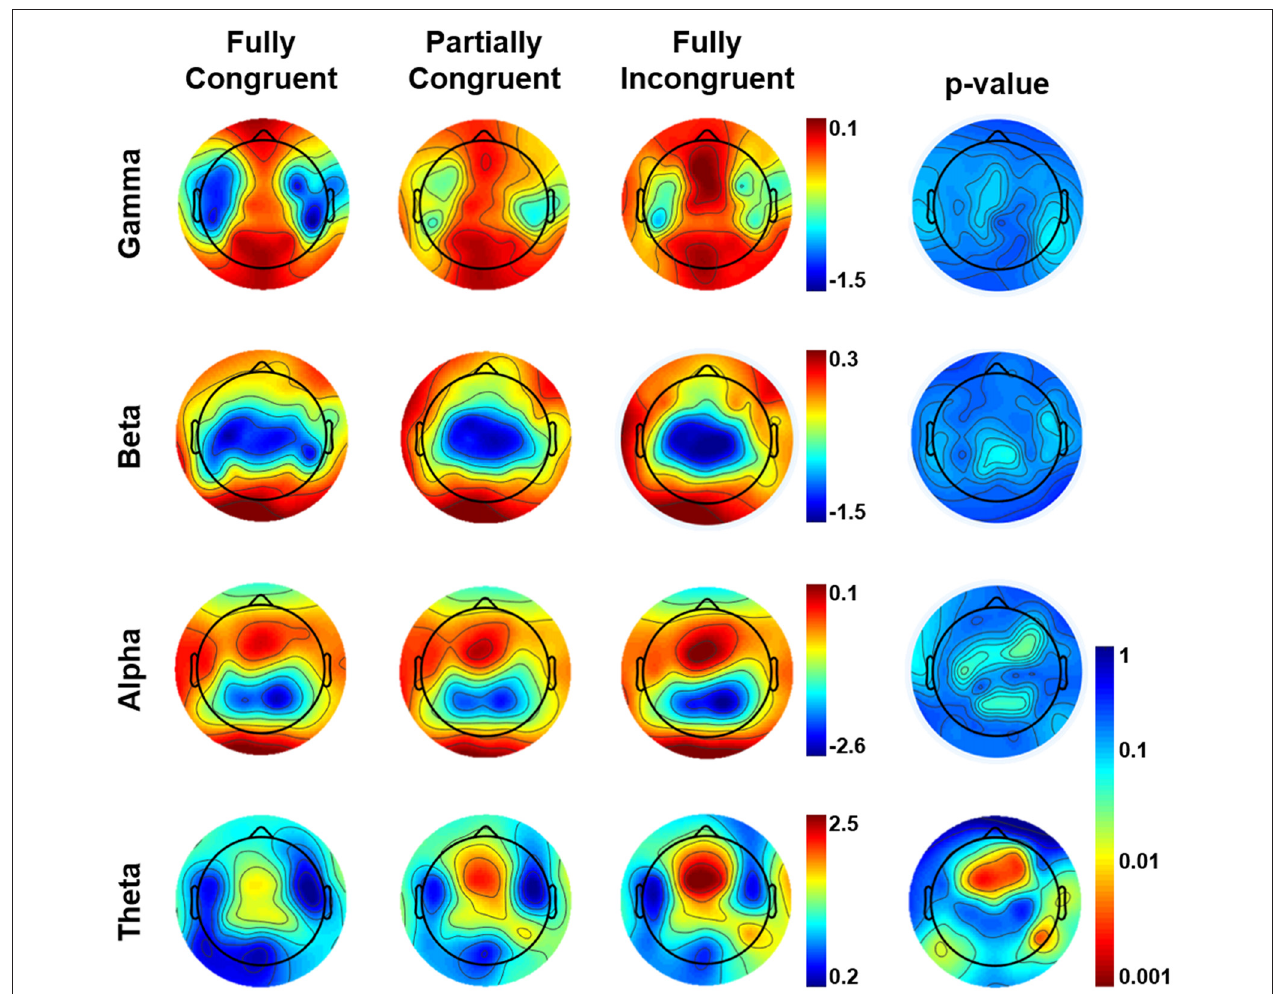
FIGURE 3 | Topographical distribution of frequency power by Condition by frequency band in the (0–500) ms time-window of interest. The most-right column shows the Bonferroni corrected p -value of the comparison across conditions. From Fully Incongruent to Partially Congruent to Fully Congruent there is an increasing amount of theta activity. To be noted that no significant differences were found for other